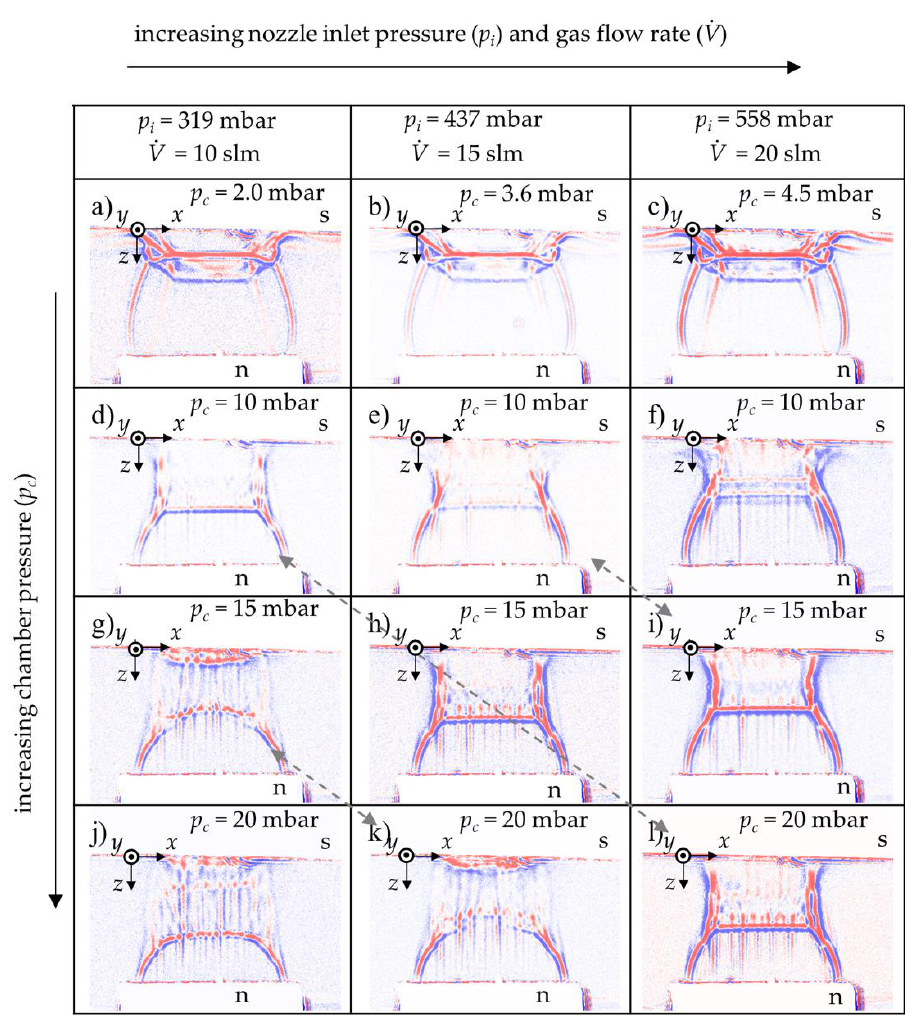
Figure 7. Expansion of carrier gas between the slit nozzle and substrate in x - z -plane (s: substrate, n: nozzle) of different parameter sets (gas flow rates and chamber pressures ( a – l )); grey dashed arrows highlight qualitatively equal shadow images at different PAD parameter sets.